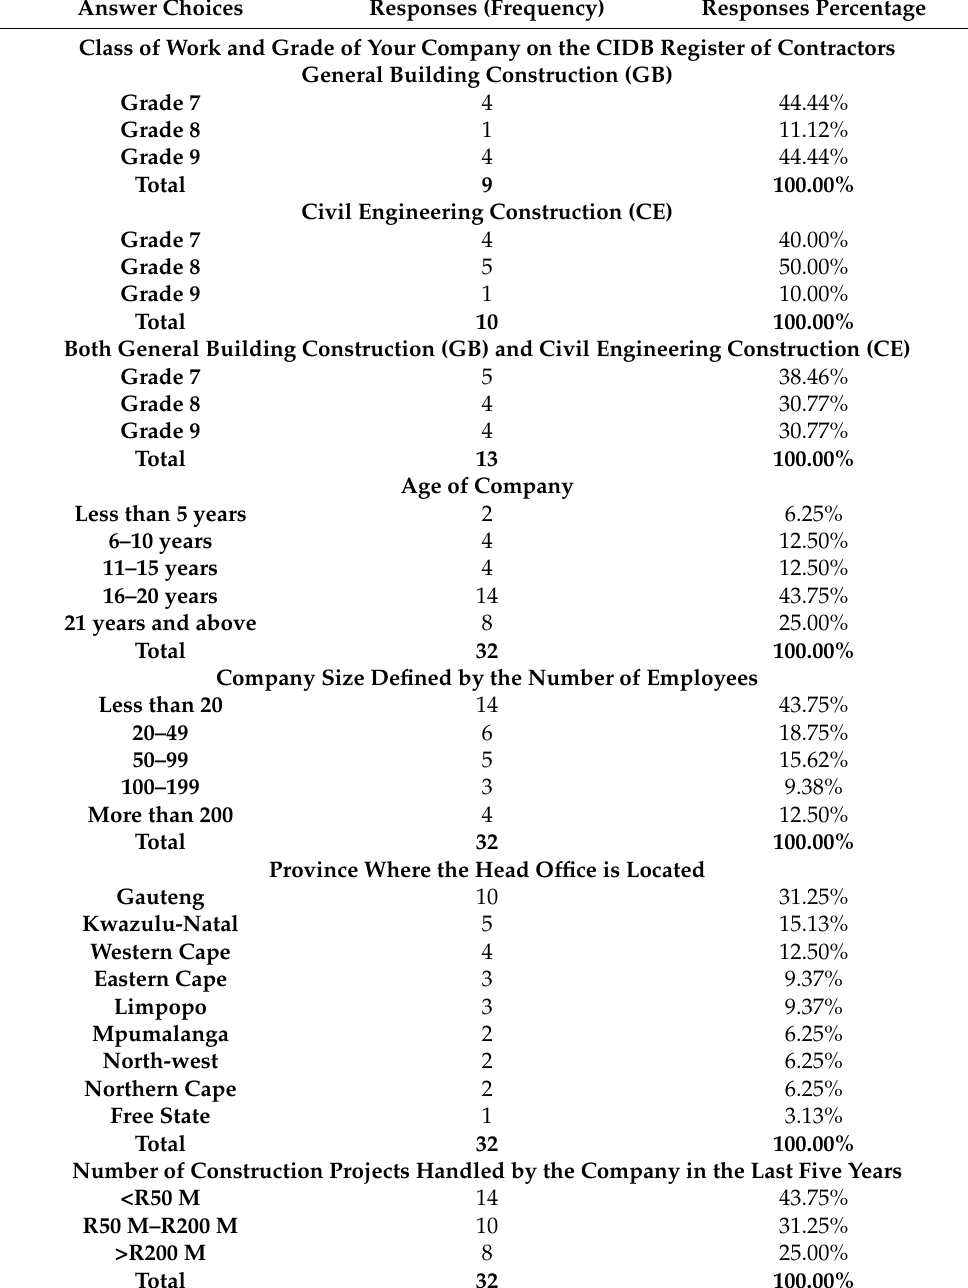
Table 3. Profile of